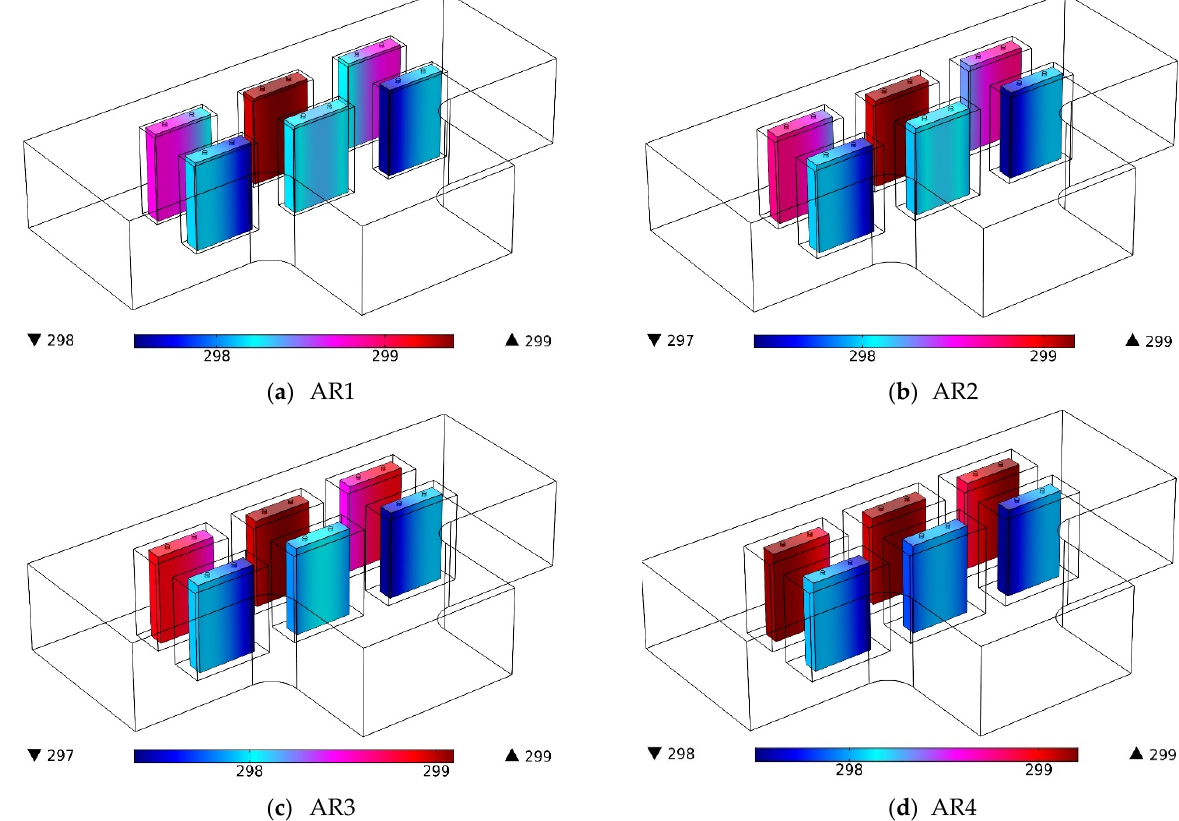
Figure 4. Temperature contours (in Kelvin) on BTCLs for different values of cavity AR.